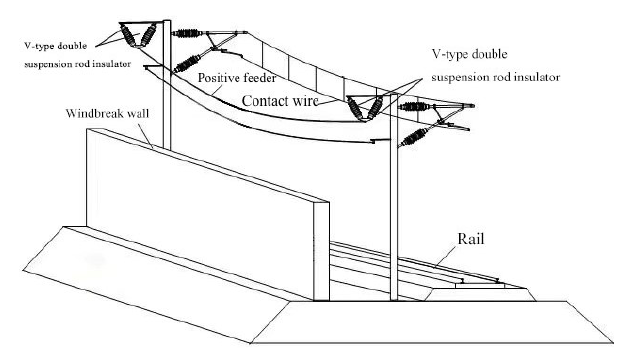
Figure 1. Diagram of catenary environment.